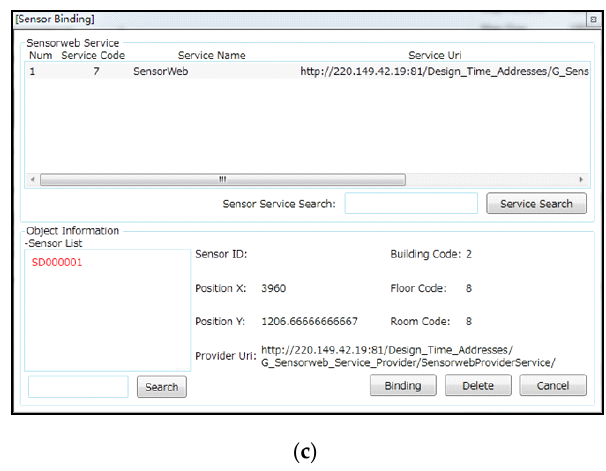
Figure 12. Geo-Sensor composite toolbox execution screen: ( a ) building information management; ( b ) floor information management; ( c ) sensor binding.